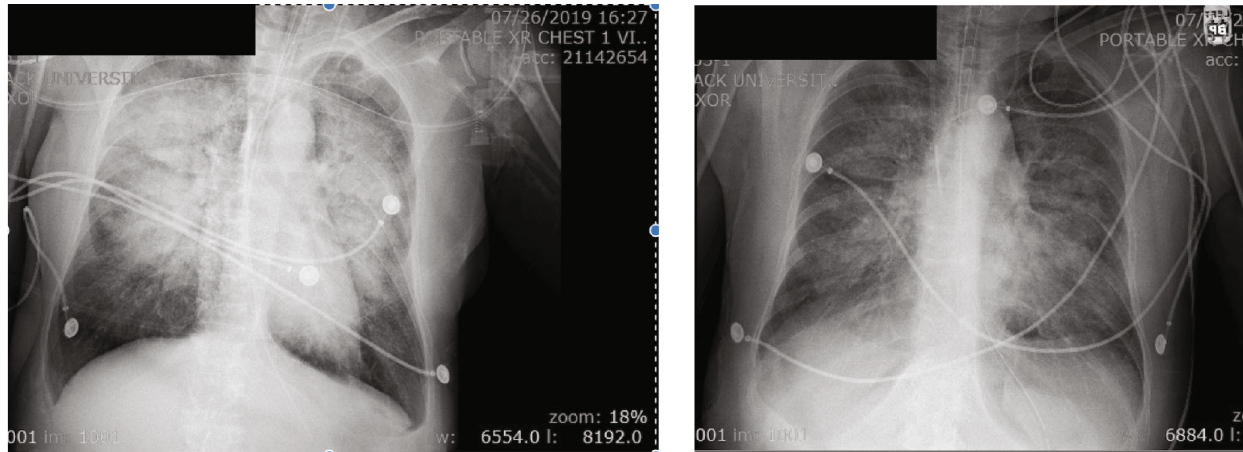
Figure 3: Chest X-ray prior to and following tocilizumab. Improvement of bilateral ground glass opacities following interleukin-6 receptor